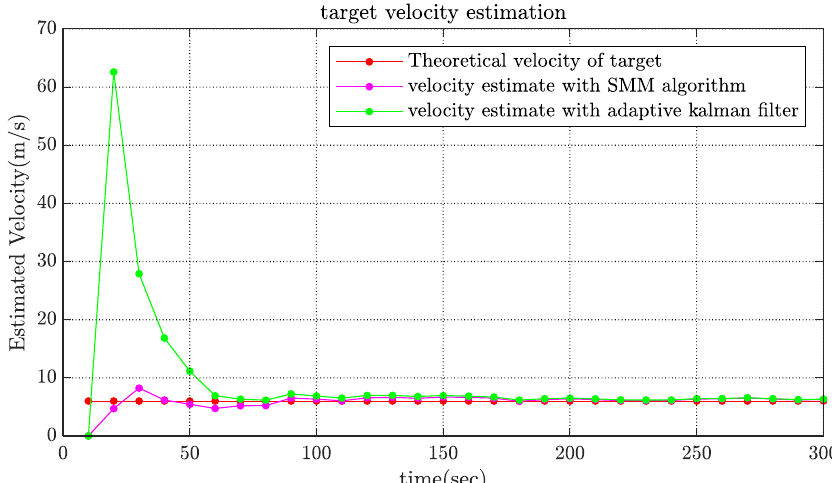
Figure 3. Comparison of estimated velocity.